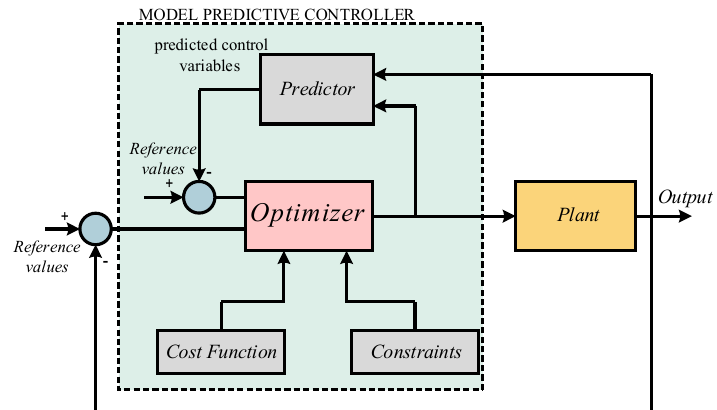
Figure 34. Block Diagram of Model Predictive Control algorithm.